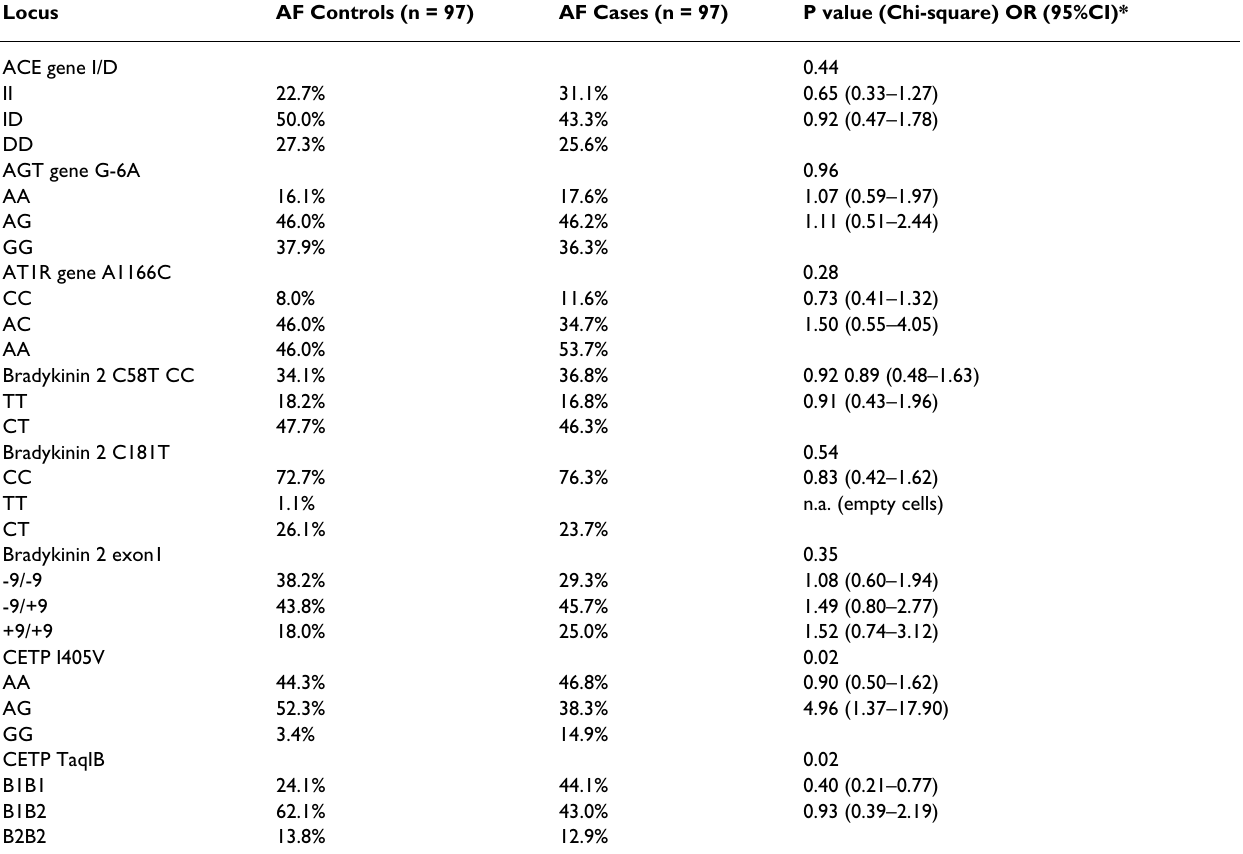
Table 2: Distribution of genotypes in controls without atrial fibrillation (AF) and subjects with AF. Locus AF Controls (n =